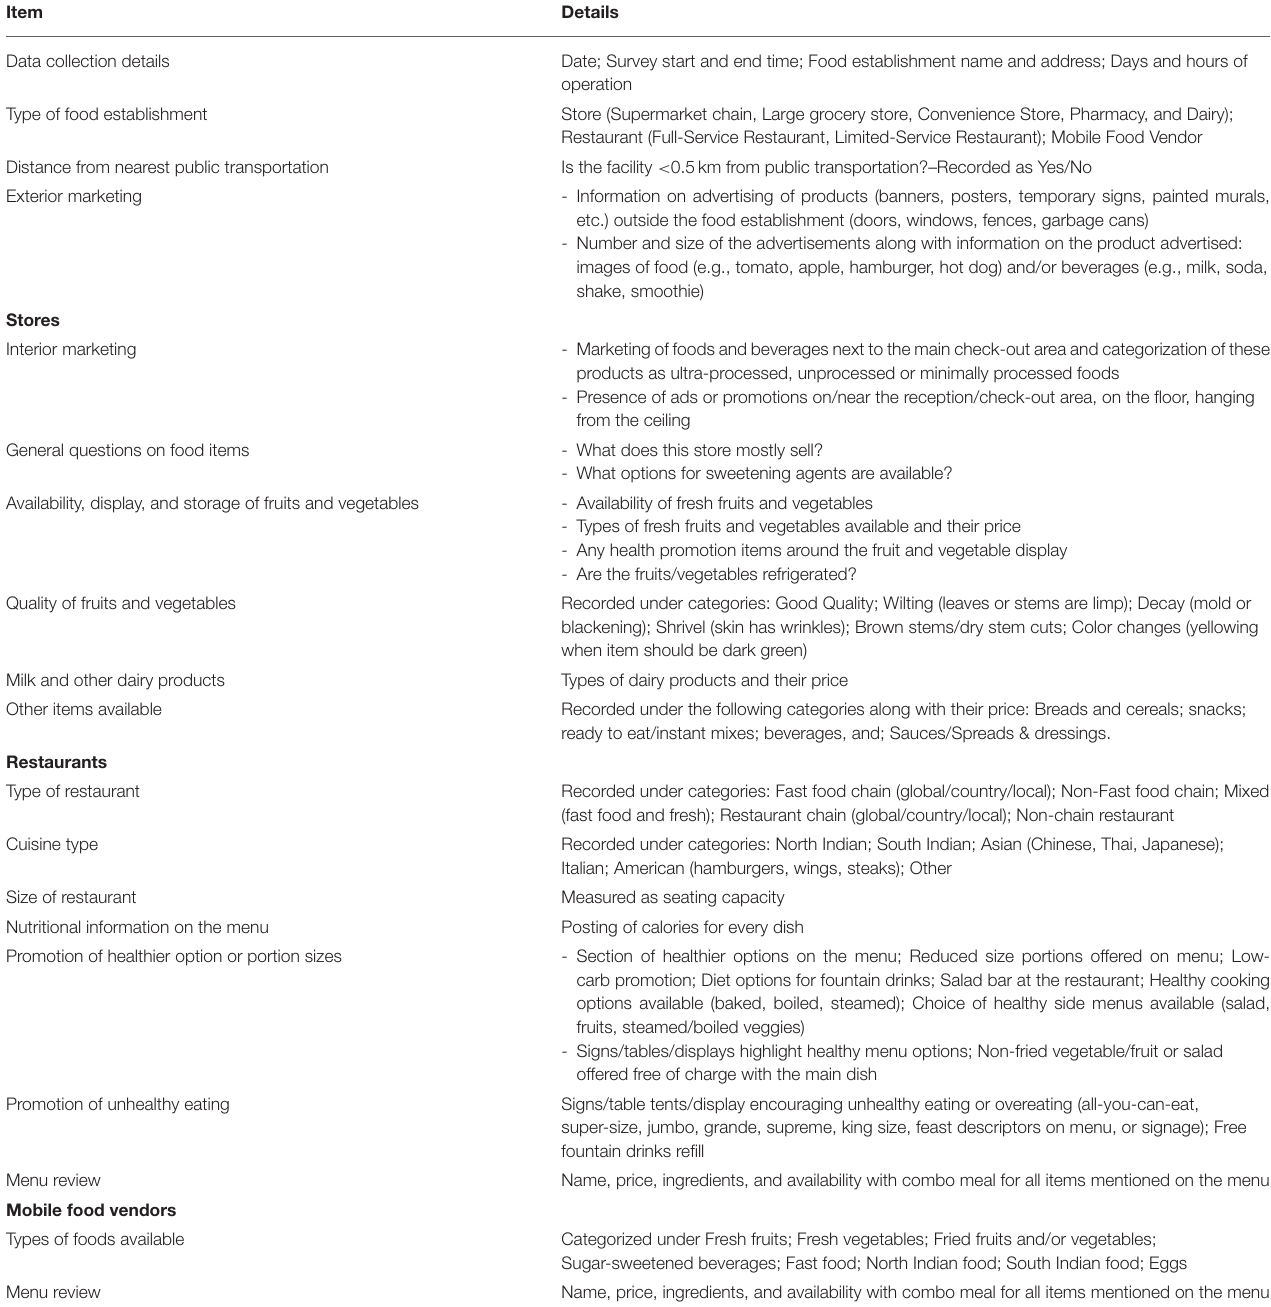
TABLE 2 | Items captured by the survey